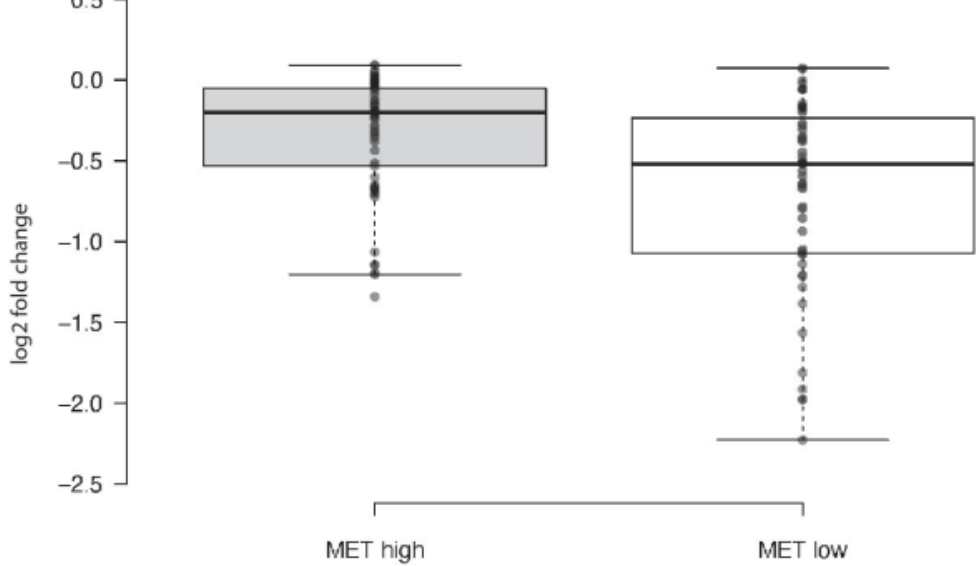
Figure 1. Susceptibility of a panel of 200 cancer cell lines to olaparib shown as box-plots. Log2 fold change of olaparib treated versus untreated cells is shown on the Y axis. Cell lines were subclassified based on MET expression according to RNAseq measured as log2 TPM+1 (transcript per kilobase million, +1). MET high: cell lines showing a level of expression greater than 6 log2(TPM+1). MET low: cell lines showing a level of expression lower than 4 log2(TPM+1). The difference between the two experimental groups was statistically significant ( p = 0.001); T -test was performed using GraphPad Prism7 software.